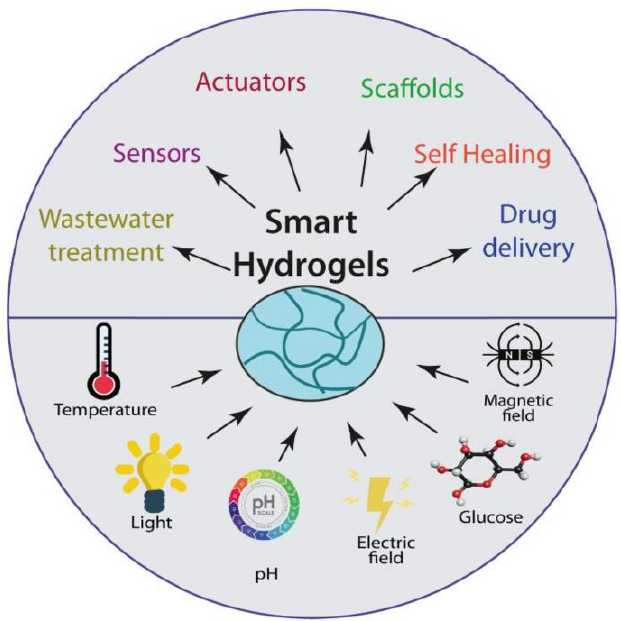
Figure 3. Stimulus-responsive hydrogels and their applications [27].